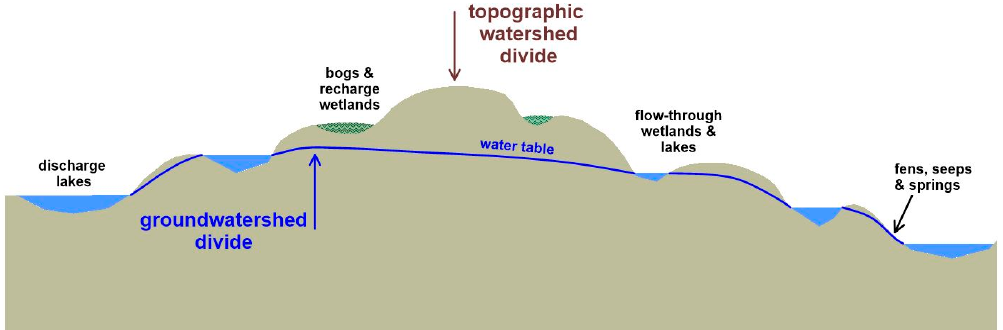
Figure 1. Examples of lake and wetland interactions with groundwater.